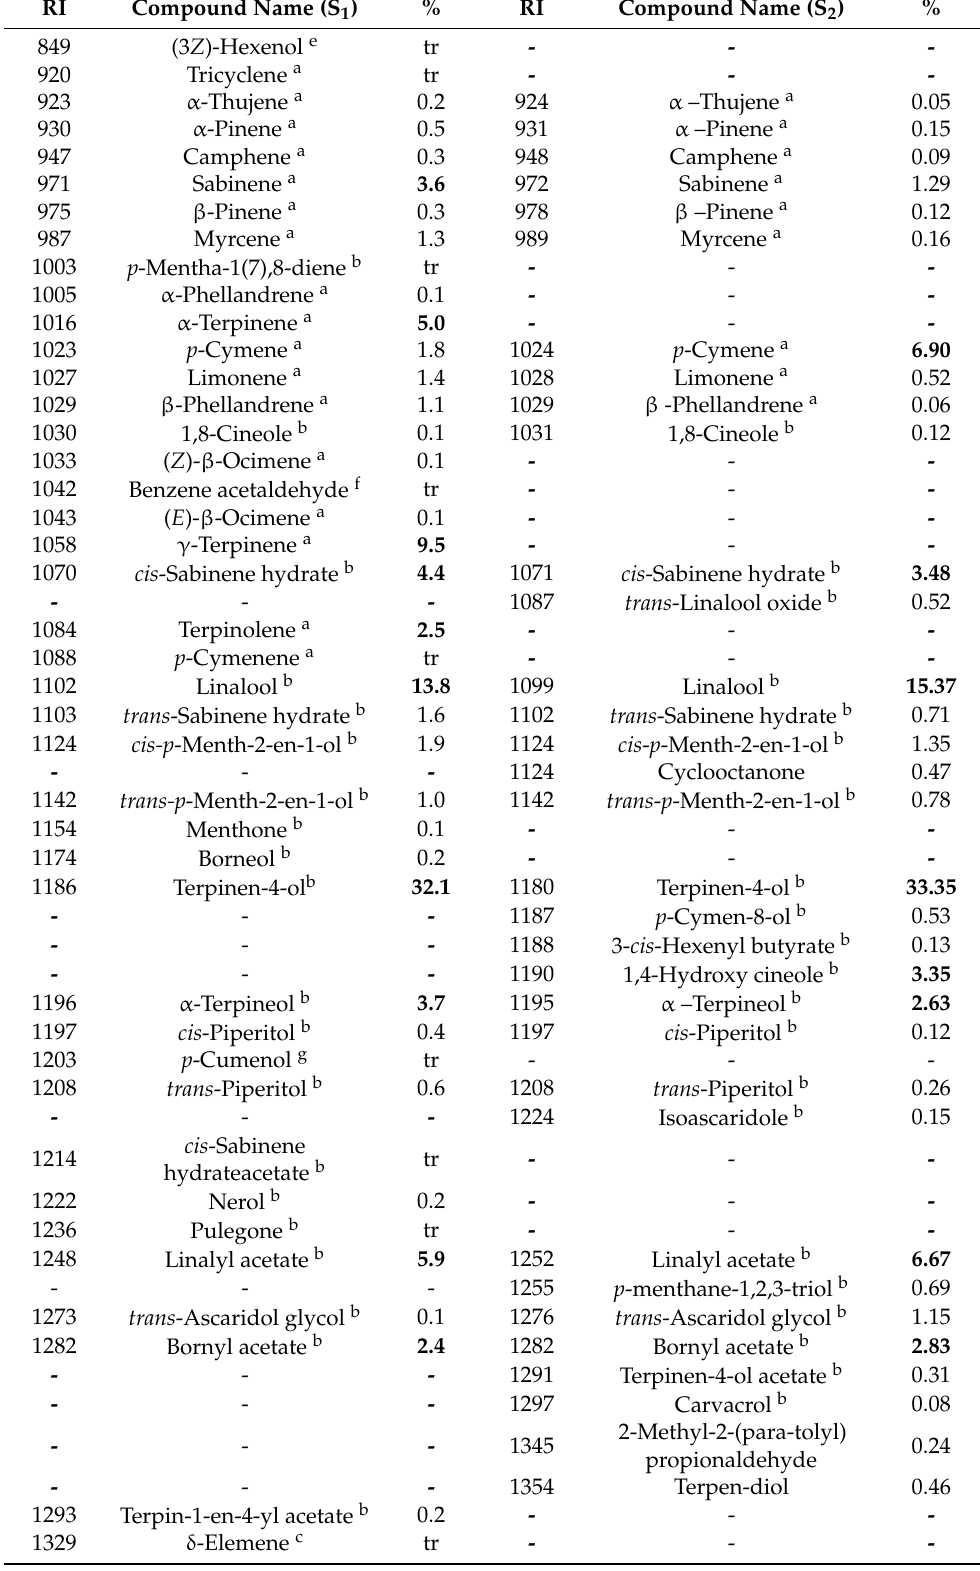
Table 1. Chemical composition of essential oils of Origanum majorana L. from